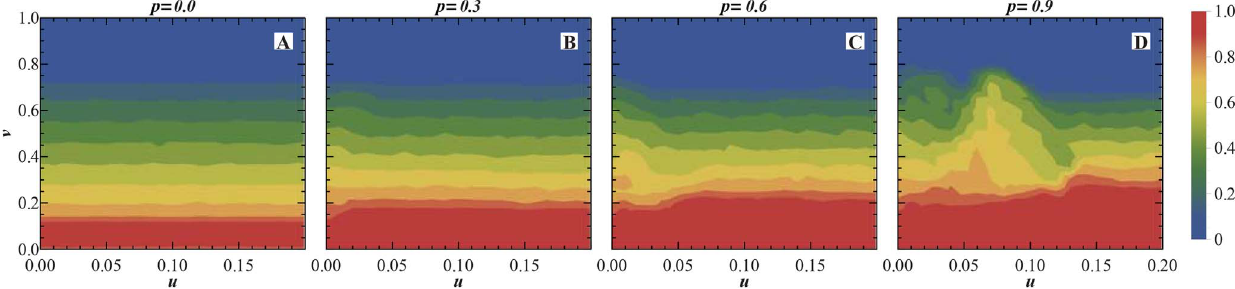
Figure 5. The fractions of SDc ~ Cc z Dc individuals in u { v parameter plane with p=0.0(pure SD population), 0.3, 0.6, 0.9. The initial average fractions of Cc , Cd , Dc , Dd are all 0 : 25 and the individuals are randomly distributed on lattices evenly in the beginning.